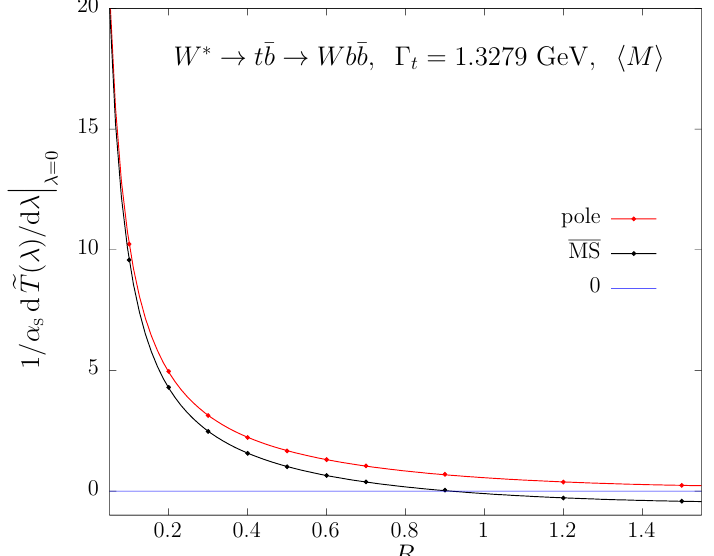
Figure 7 . R dependence of the slope of e T for the averaged reconstructed mass M . The solid lines are the result of a (cid:12)t of the form a=R + b + c R + d R 2 .